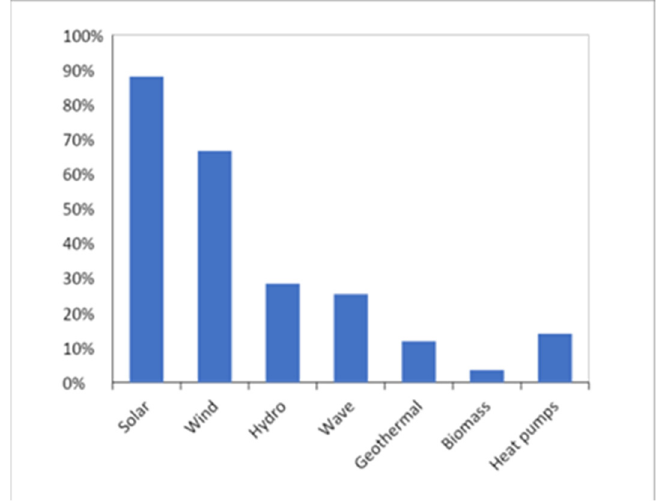
Figure 3. Replies to the question, “What type of renewable energy technologies do you know?”.